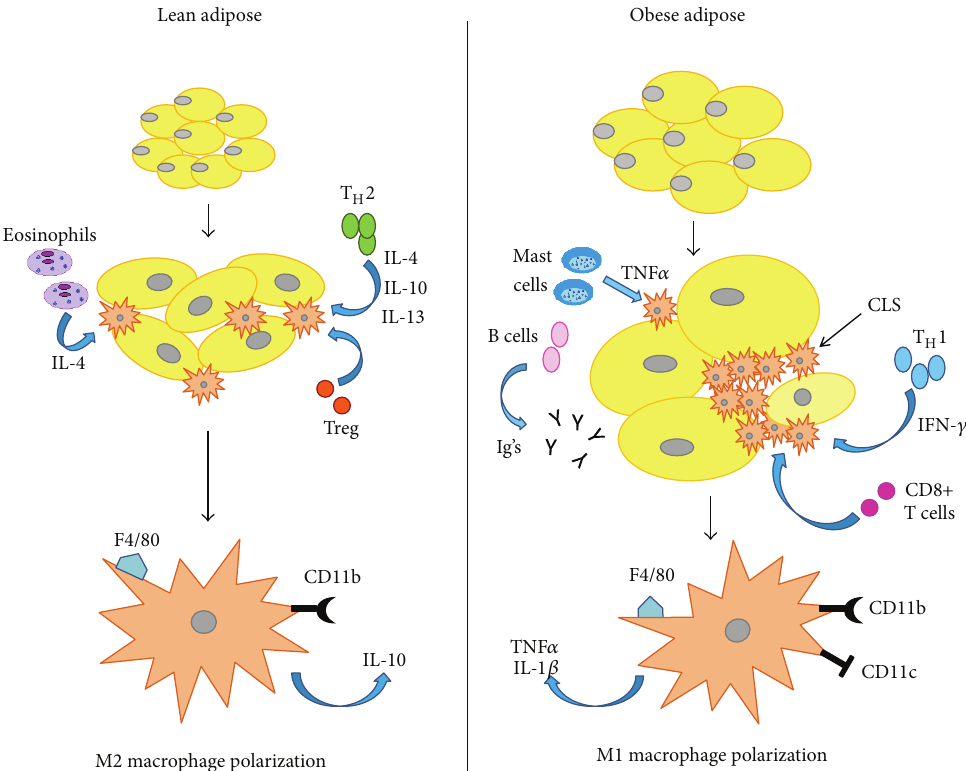
2 ) cells produce Figure 1: Role of the immune system in lean versus obese adipose tissue. In lean adipose tissue, T-helper type 2 (T H anti-inflammatory cytokines such as interleukin (IL)-4, 10, and 13 which promote alternatively activated M2 macrophage polarization. M2 polarization is also induced by regulatory T cells (Tregs) and eosinophils via IL-4. M2 macrophages secrete other anti-inflammatory signals 1 typecytokinessuchasinterferon(IFN)- 𝛾 stimulate suchasIL-10whichmaintaininsulinsensitivitywithinleanadiposetissue.Conversely,T H M1 macrophage polarization in obese adipose tissue. Other immune cells are also increased in obese adipose tissue which contribute to insulin resistance including mast cells, B cells, and immunoglobulins (Igs). CD8(+) T cells promote ATM accumulation and proinflammatory gene expression and are also increased as well. Macrophages are not homogenously distributed throughout obese adipose tissue but rather aggregated around dead adipocytes forming crown-like structures (CLS). M1 macrophages are proinflammatory, secreting cytokines such as TNF- 𝛼 and IL-1 𝛽 . Macrophages are bone-marrow-derived myeloid cells hence both M1 and M2 macrophages express the myeloid cell surface markers F4/80 and CD11b. However, only the M1 population expresses the marker